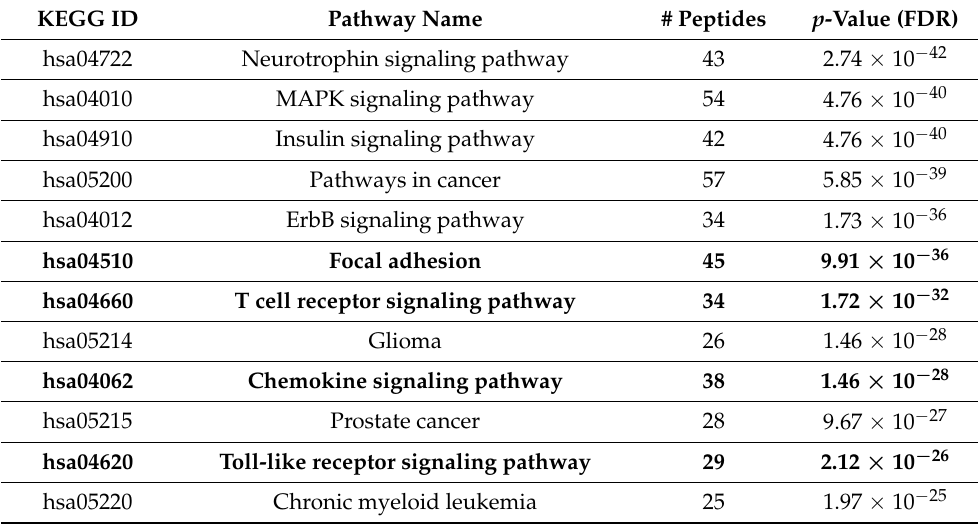
Table 8. Top 12 KEGG pathways in the sub-iliac lymph nodes collected from feedlot cattle at slaughter in the summer and winter months. A list of representive pathways was generated by utilizing the statistically significant peptides from the comparison and inputting these peptides into the online STRING database. Presented below are the top 12 pathways. The bold pathways are those involved in the immune response (total immune peptides: 146).